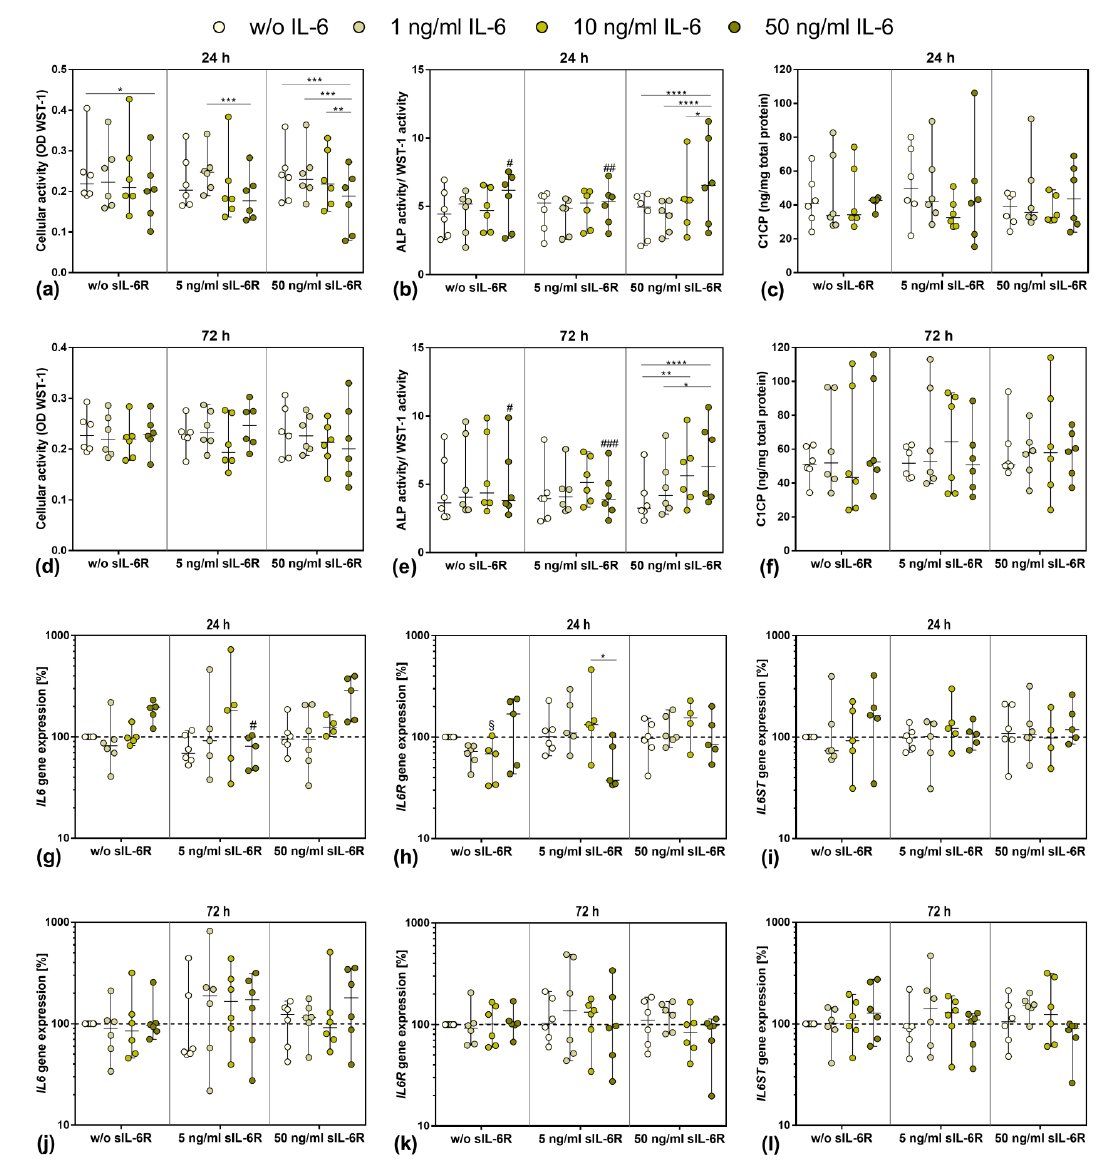
Figure 2. Influence of different IL-6 and sIL-6R concentrations on osteoblastic viability and differentiation capacity after 24 h ( a – c ; g – i ) and 72 h ( d – f ; j – l ) of exposure. ( a , d ) Cell viability was tested via water-soluble tetrazolium salt (WST) 1 assay ( n = 6 independent donors (passage 3; female: n = 1, male: n = 5); mean age: 71.5 ± 11.6 year). ( b , e ) Alkaline phosphatase (ALP) activity of osteoblasts, which was quantified via hydrolysis of p-nitrophenylphosphate ( n = 6 independent donors (passage 3; female: n = 1, male: n = 5); mean age: 71.5 ± 11.6 year). ( c , f ) Release of c-terminal propeptide of collagen type 1 (C1CP) in the cell culture supernatant ( n = 6 independent donors (passage 3; female: n = 1, male: n = 5); mean age: 71.5 ± 11.6 year). ( g – l ) Gene expression analysis of IL6, IL6R, and IL6ST in human osteoblasts (24 h: n = 4 – 6 independent donors, 72 h: n = 6 independent donors (passage 3; female: n = 1, male: n = 5); mean age: 71.5 ± 11.6 year). Results were calculated by 2 −ΔΔCt method (% unstimulated control). All data are shown as box plots. Statistical significance was determined via two-way ANOVA or repeated-measures two-way ANOVA with Bonferroni’s post hoc test: * p < 0.05, ** p < 0.01; *** p < 0.001, **** p < 0.0001 (significance between IL-6 concentrations); § p < 0.05 (significantly different from sample with same IL-6 concentration at 5 ng/mL sIL-6R); # p < 0.05; ## p < 0.01; ### p < 0.001 (significantly different from sample with same IL-6 concentration at 50 ng/mL